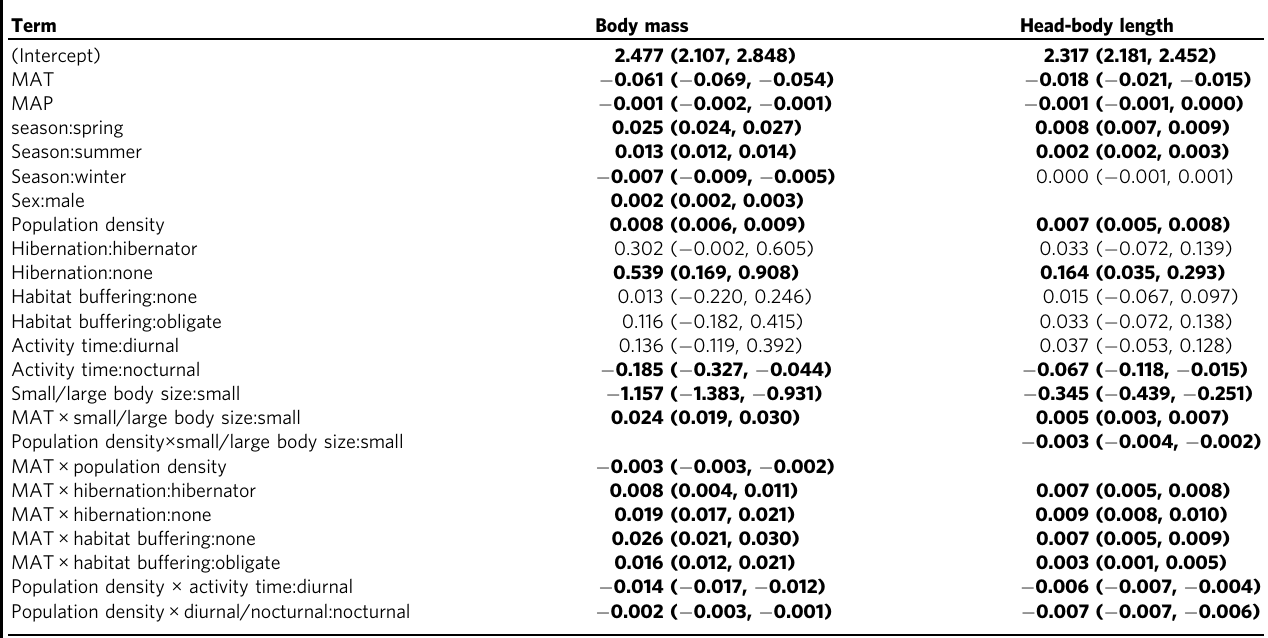
Table 1 Fixed effect coef fi cients for the top body mass and head-body length phylogenetic generalized linear mixed models